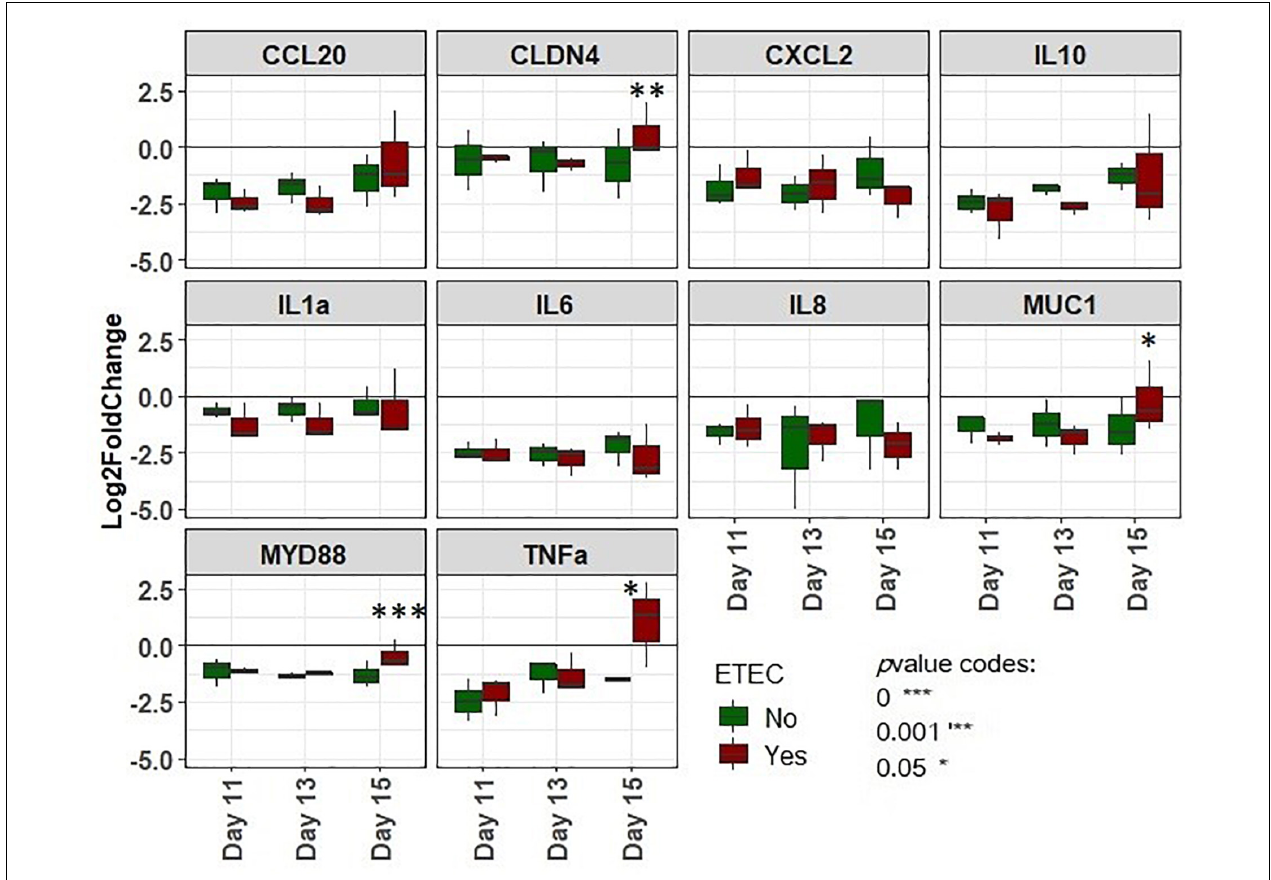
FIGURE 10 | Log2 fold changes of gene expression of IPI-2I cells incubated with bead medium supernatants of the MPigut-IVM collected at days 11, 13, and 15 and challenged or not with the ETEC Ec105 strain. Values were normalized with basal gene expression profiles for the targeted genes from IPI-2I cells incubated with their usual glutamine and FCS complemented DMEM medium ( n =